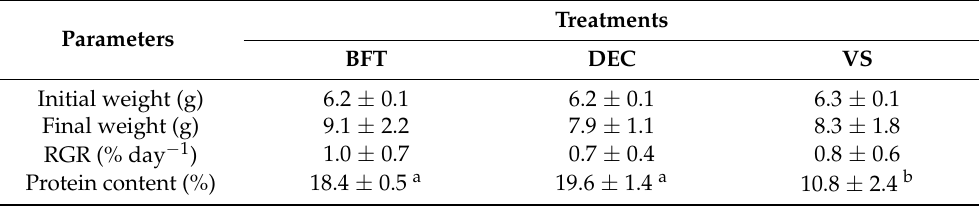
Table 2. Initial and final biomass, relative growth rates, and protein contents (% of dry weight) (mean ± standard deviation) of U. lactuca growth in the treatments of BFT (in shrimp culture effluent with 400 mg L − 1 of TSS), DEC (in effluent from shrimp culture after the settling period, with 30 mg L − 1 of TSS) and VS. (cultivation of U. lactuca in standard von Stosch enrichment solution at a concentration of 10 mL L − 1 ) during the 35 days of the experimental period.